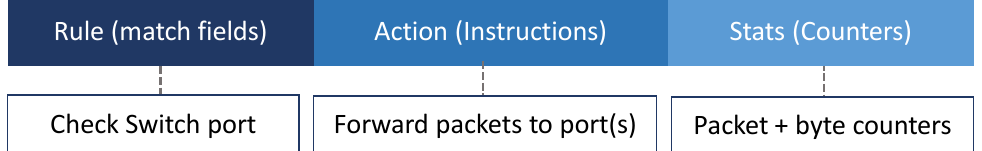
Figure 6. SDN OpenFlow flow entry